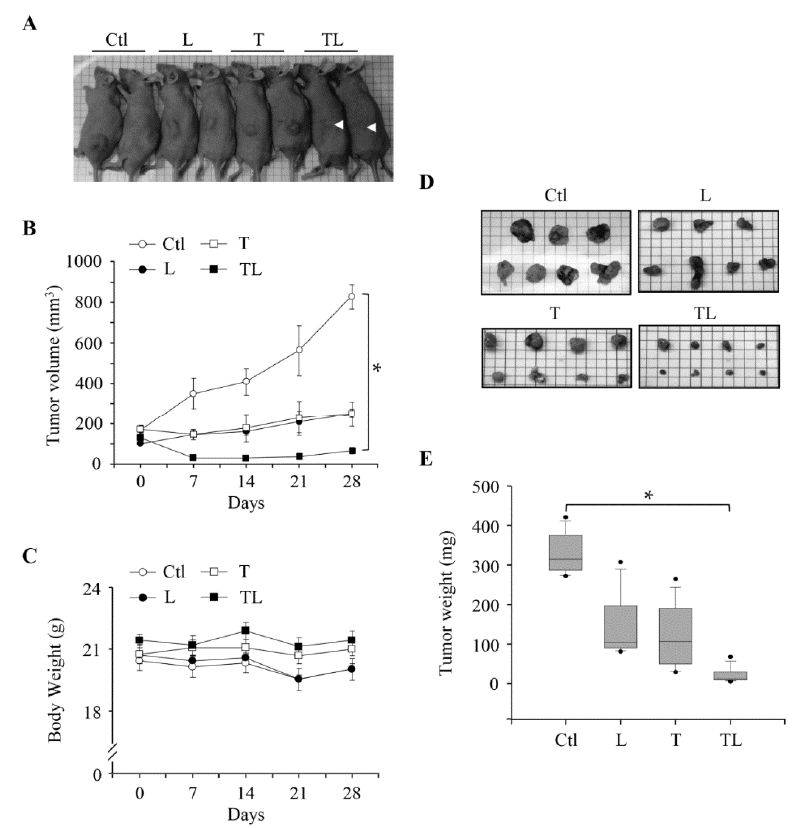
Figure 4. Combined administration of troglitazone and lovastatin restrained tumor progression in a mouse xenograft model. Human ATC SW1736 cells were subcutaneously inoculated in the left-lower dorsum of Bagg’s albino (BALB)/c nude mice and the cells were allowed to grow up and form a solid tumor. After tumors reached up to a size of ~200 mm 3 , phosphate-buffered saline (PBS) or drugs were administered daily via intraperitoneal injection, five times a week for 4 weeks. ( A ) Represented mice bearing tumor xenografts. ( B ) Monitoring the tumor volume following drug administration. ( C ) The body weight of mice among each group was not significantly changed during treatment. ( D ) The solid tumors in each group at the end of treatment. ( E ) Measurement of the tumor weight in mice bearing tumor xenografts following drug treatments. Values represent the means ± S.E.M. (Ctl: n = 7; T: n = 8; L: n = 7; TL: n = 8). Black dot: single data point. Arrowhead: reduction in tumor size. * p < 0.05. Ctl: control; L: lovastatin (2 mg/kg/day); T: troglitazone (5 mg/kg/day); TL: combination of troglitazone and